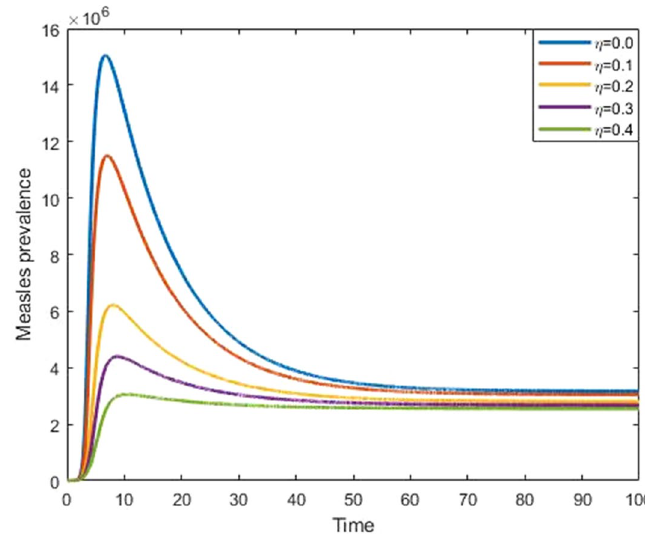
Figure 11. Impact of first dose vaccine ( η ) on measles prevalence.